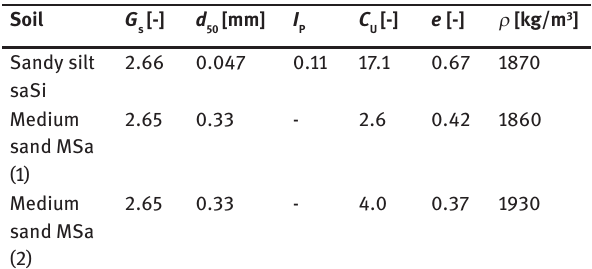
Table 1: Parameters of tested soils.